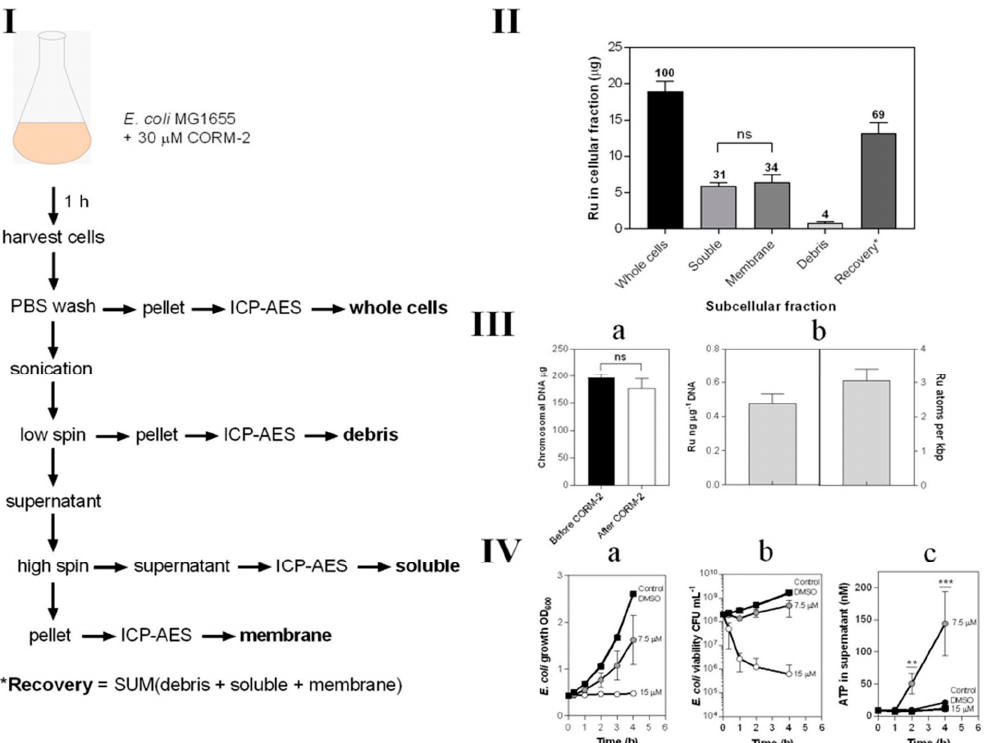
Figure 7. Subcellular distribution of CORM-2-derived Ru(II). ( I ) Scheme demonstrating the process for preparation of subcellular fractions of E. coli for quantification of Ru content by ICP-AES. ( II ) The Ru content of each subcellular fraction displaying the percentage of total Ru recovered in each fraction by ICP-AES. ( III ) Localisation of CORM-2-derived Ru on E. coli chromosomal DNA. ( IIIa ) the amount of chromosomal DNA recovered from 20 mL E. coli cell cultures before (black bar) and after 1 h incubation with 30 μ M CORM-2 (white bar). ( IIIb ) the amount of Ru (ng) detected per μ g of DNA as determined by ICP-AES of chromosomal DNA samples from cells treated for 1 h with 30 μ M CORM-2 and the amount of atoms of Ru per kbp of DNA. ( IV ) Sub-toxic doses of CORM-2 cause ATP leakage from E. coli cells. The extent of growth inhibition ( IVa ) and loss in cellular viability ( IVb ) upon addition of 0–15 μ M CORM-2 (t = 0 h) to E. coli cultures grown on GDMM. ( IVc ) Amount of ATP (nM) detected in the supernatant of E. coli cells upon exposure to no CORM, DMSO or sub-toxic (7.5 μ M) or toxic (15 μ M) levels of CORM-2 (** = p ≤ 0.01, *** = p ≤ 0.001). All data in II – IV are representative of 3 biological repeats ± SD. Significance differences were assessed via unpaired t-tests.